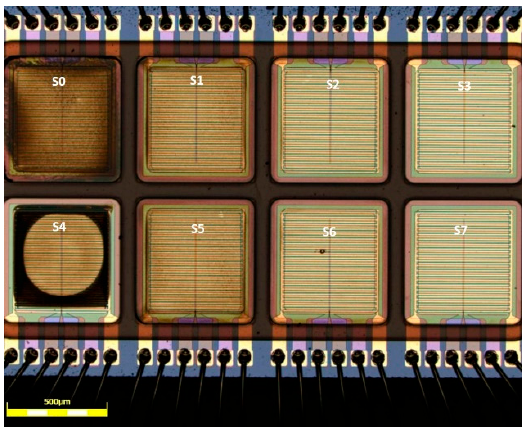
Figure 1. Optical microscope picture of the 8 sensor fields after printing and drying.